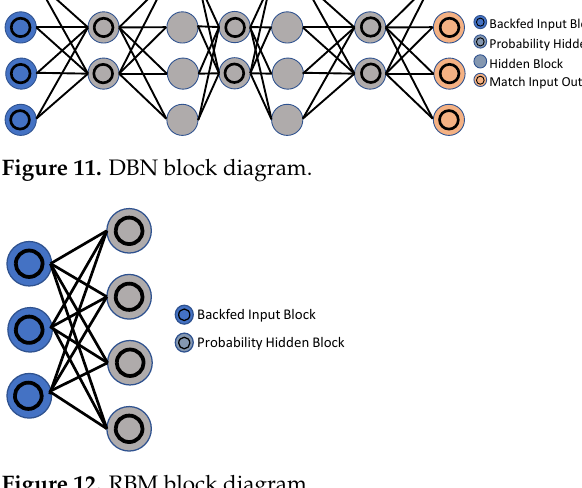
Figure 12. RBM block